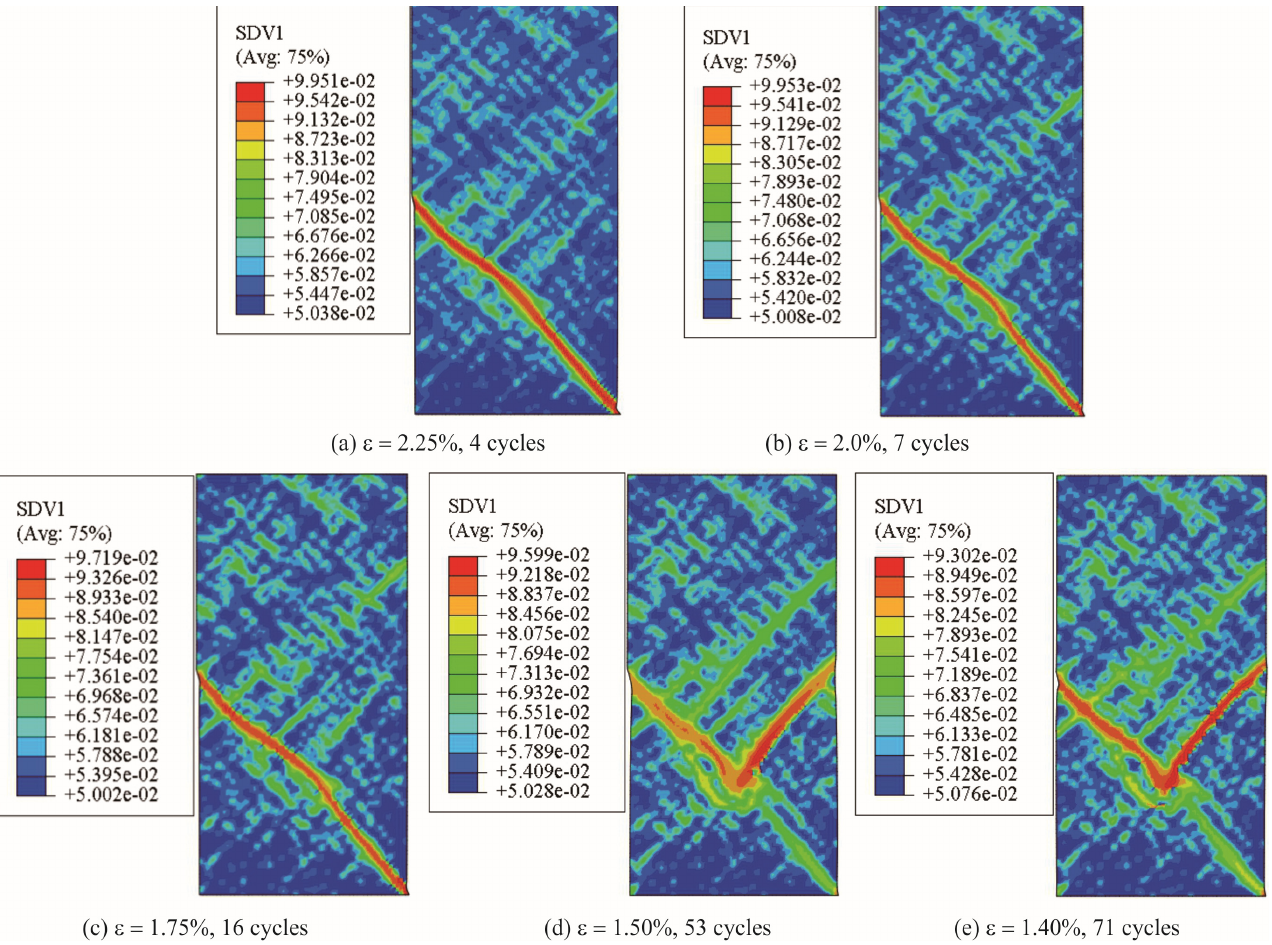
Figure 6. Contour plot of shear band morphology at fatigue limit. ( a ) ε = 2.25%, 4 cycles; ( b ) ε = 2.0%, 7 cycles; ( c ) ε = 1.75%, 16 cycles; ( d ) ε = 1.50%, 53 cycles; ( e ) ε = 1.40%, 71 cycles.